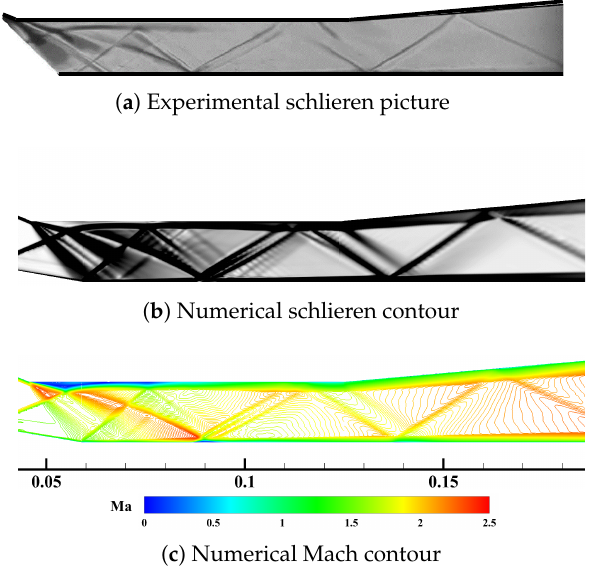
Figure 8. Comparison of experimental and numerical